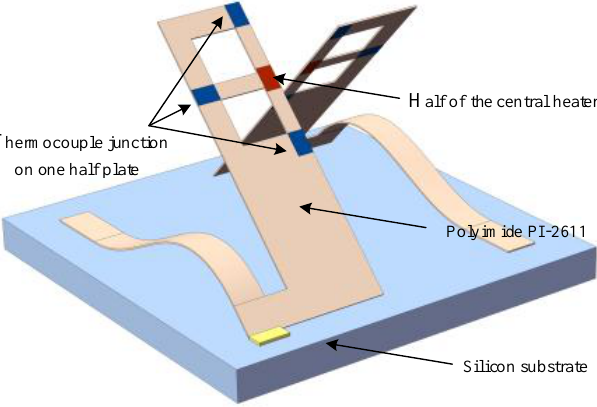
Figure 5. Illustration of tri-axis thermal accelerometer based on buckled cantilever microstructure.